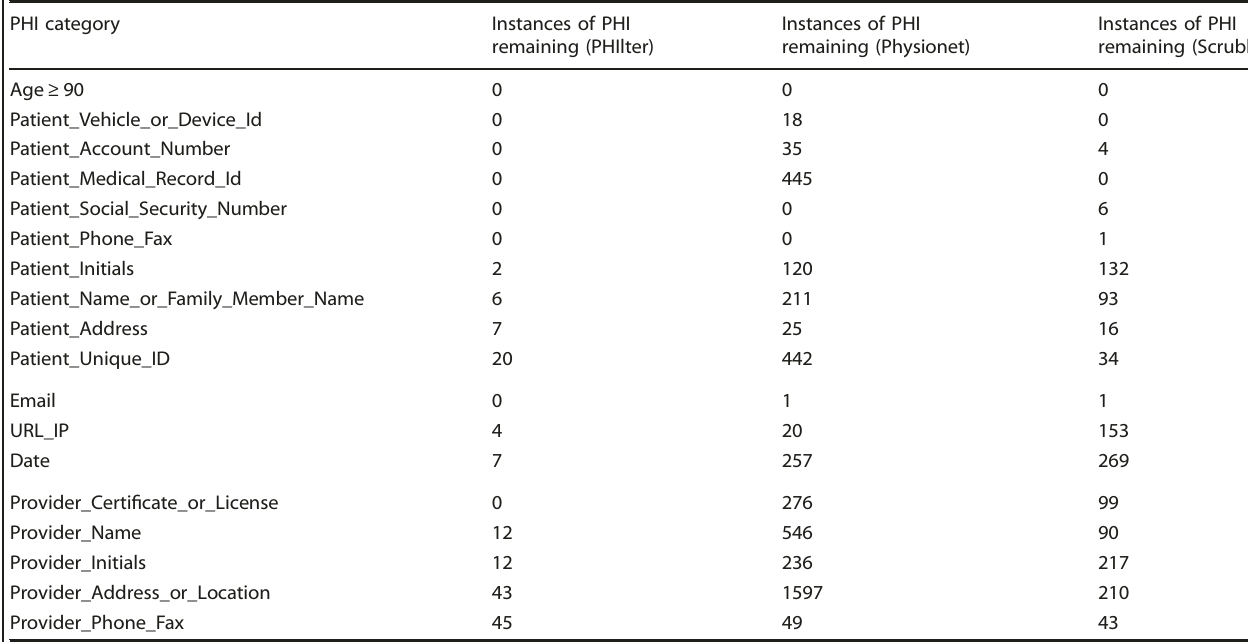
Table 2. Remaining PHI analysis by tool, UCSF test corpus. PHI